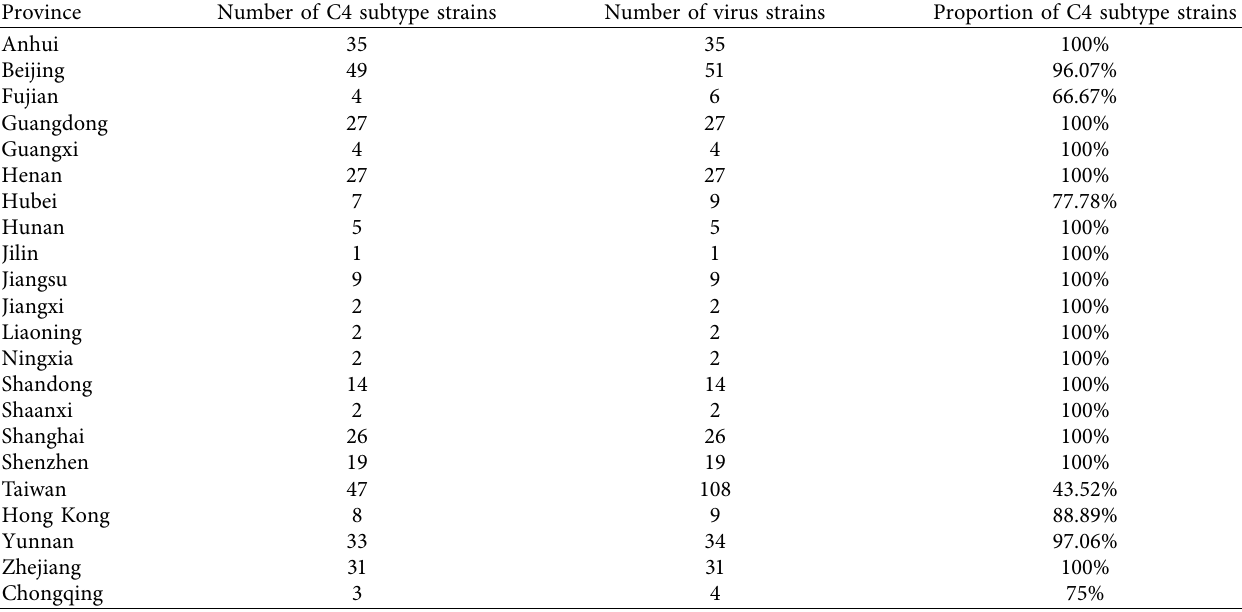
Table 2: Proportion of C4 subtypes of EV-A71 strains in each province.